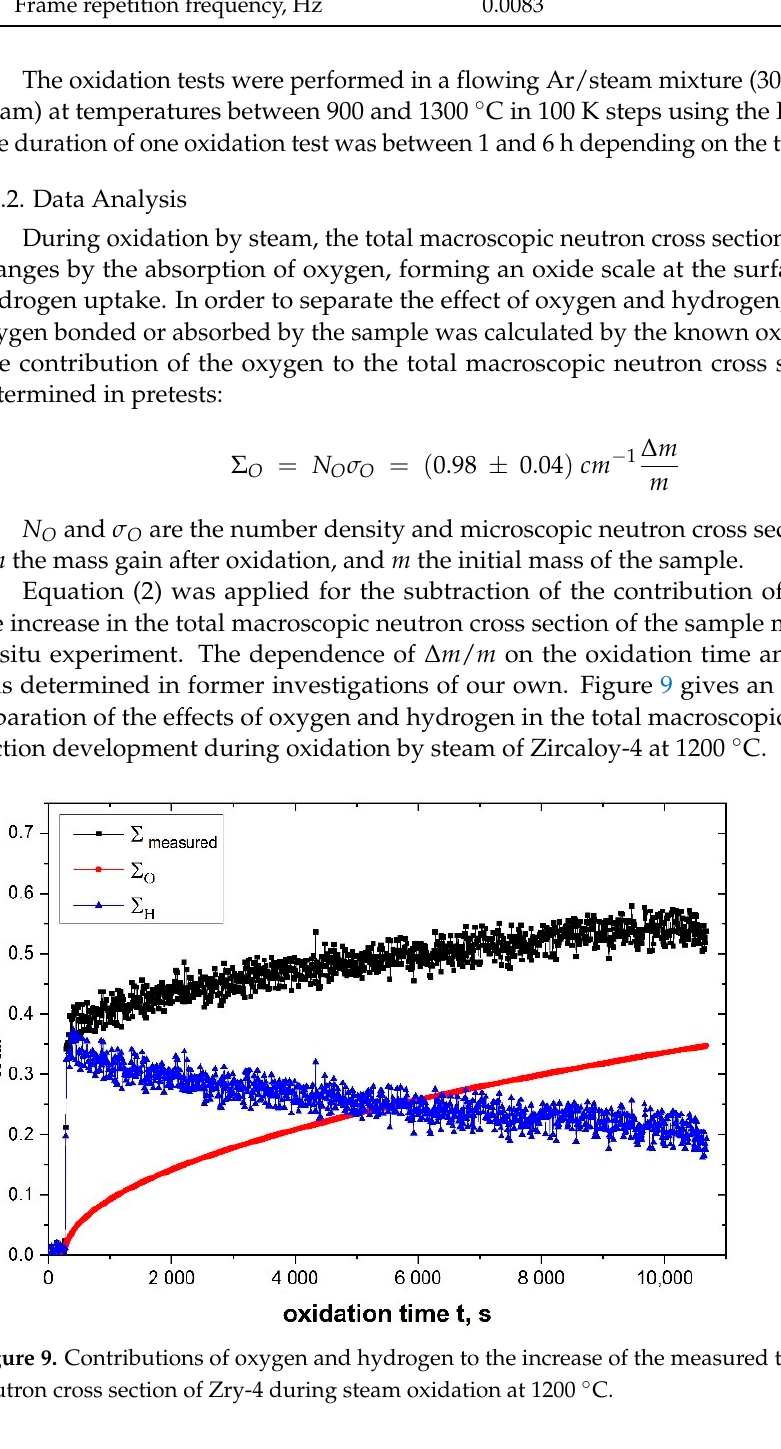
Table 1. Parameters of the in situ neutron radiography measurements.